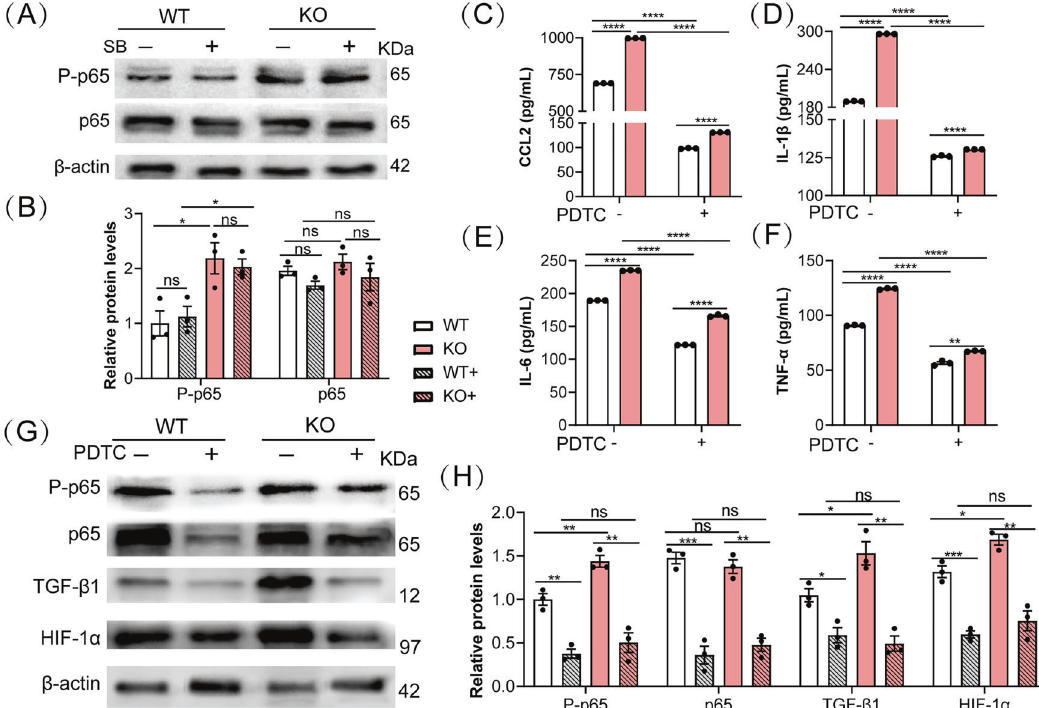
Fig. 6 Genetic disruption of Mybpc3 enhanced NF- κ B signaling pathway in fi broblasts. A , B Western blotting analysis of phosphorylated and total p65 in WT and MYBPC3-KO fi broblasts treated with or without SB-431542 (10 µM). C – F ELISA measurements of the cytokine levels of CCL2, IL-1 β , IL-6, and TNF- α in culture supernatant of WT and MYBPC3-KO fi broblasts treated with or without PDTC (10 µM). G , H Western blotting analysis of phosphorylated and total p65, TGF- β 1, and HIF-1 α in WT and MYBPC3-KO fi broblasts treated with or without PDTC (10 µM). * P < 0.05; ** P < 0.01; *** P < 0.001; **** P < 0.0001; ns, not signi fi